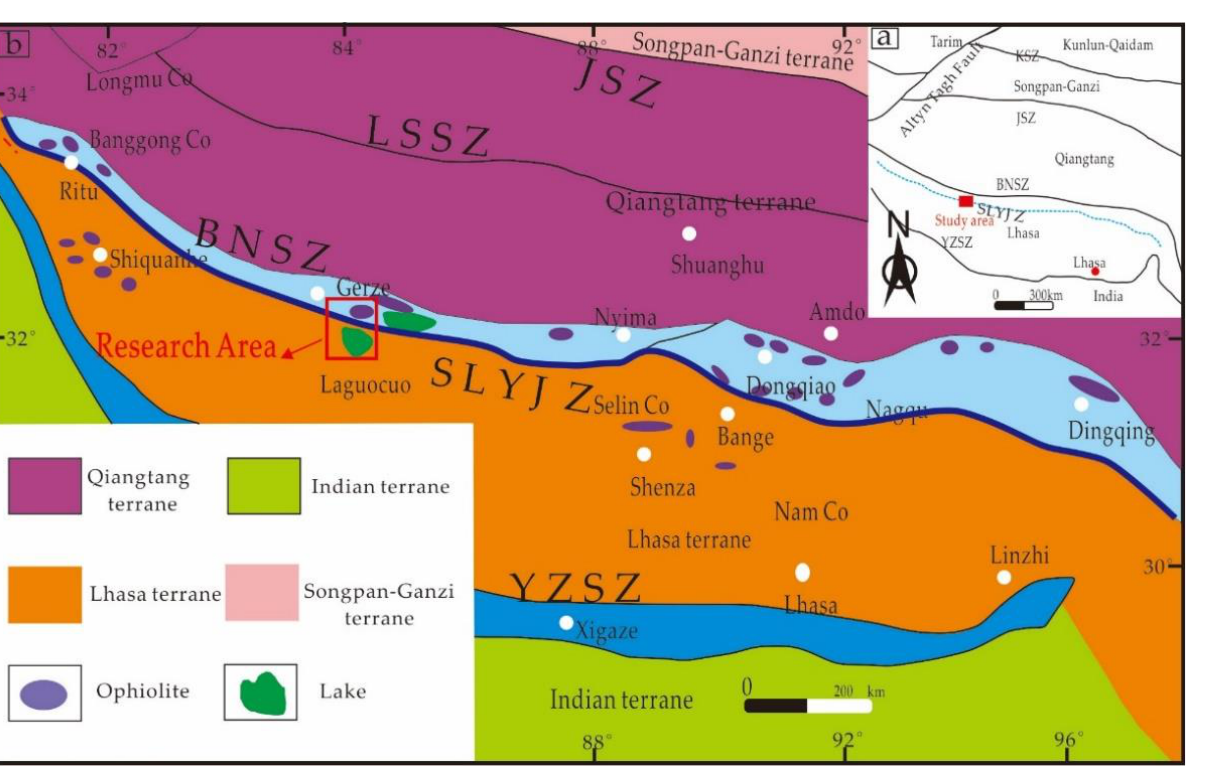
Figure 1. ( a ) The main geotectonic units of eastern Asia. ( b ) The simplified geotectonic map of the Tibetan Plateau from the Shiquanhe – Laguoco – Yongzhu – Jiali zone was modified after [12]. KSZ: the Kunlun – Qaidam suture zone, JSZ: the Jinsha suture zone, LSSZ: the Longmuco – Shuanghu suture zone, BNSZ: the Bangong – Nujiang suture zone, YZSZ: the Yarlung – Zangbo suture zone. Fan Shuaquan et al. [20] argued that the SLYJZ suture zone formed in a supra sub- duction zone tectonic environment and is an SSZ-type (the supra subduction zone) ophi- olite. Previous investigations have dated the Laguoco Tso ophiolite to the Jurassic – Early Cretaceous on the following basis: (1) Regarding the age of the Laguoco Tso ophiolite, the disagreement relates to whether it originated in the Middle Jurassic or Early Cretaceous.